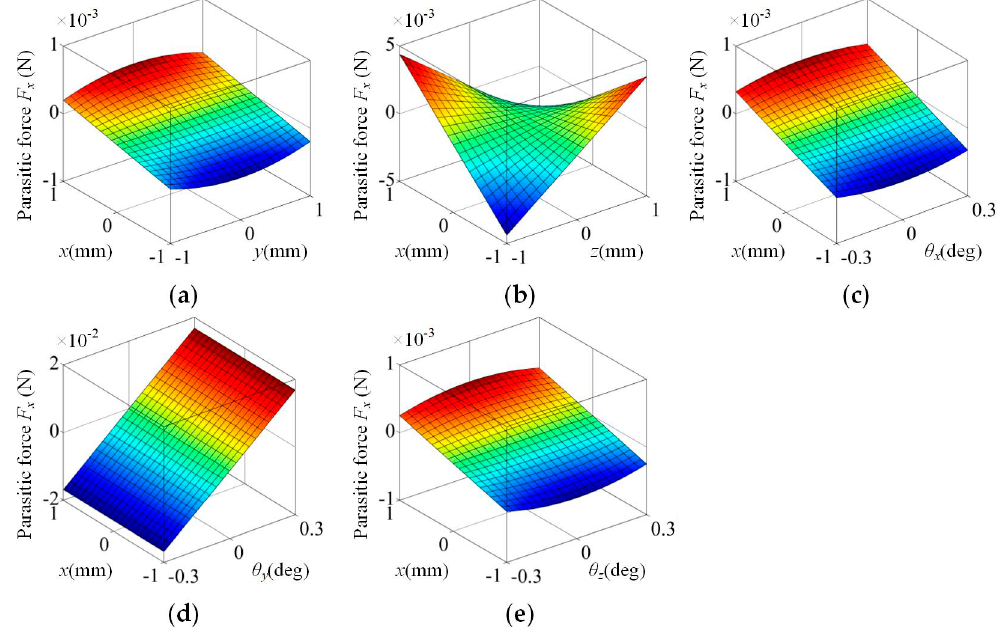
Figure 7. Parasitic force F x characteristic of the HMF-VCA varied with the mover’s motion. ( a ) F x vs. x and y . ( b ) F x vs. x and z . ( c ) F x vs. x and θ x . ( d ) F x vs. x and θ y . ( e ) F x vs. x and θ z .